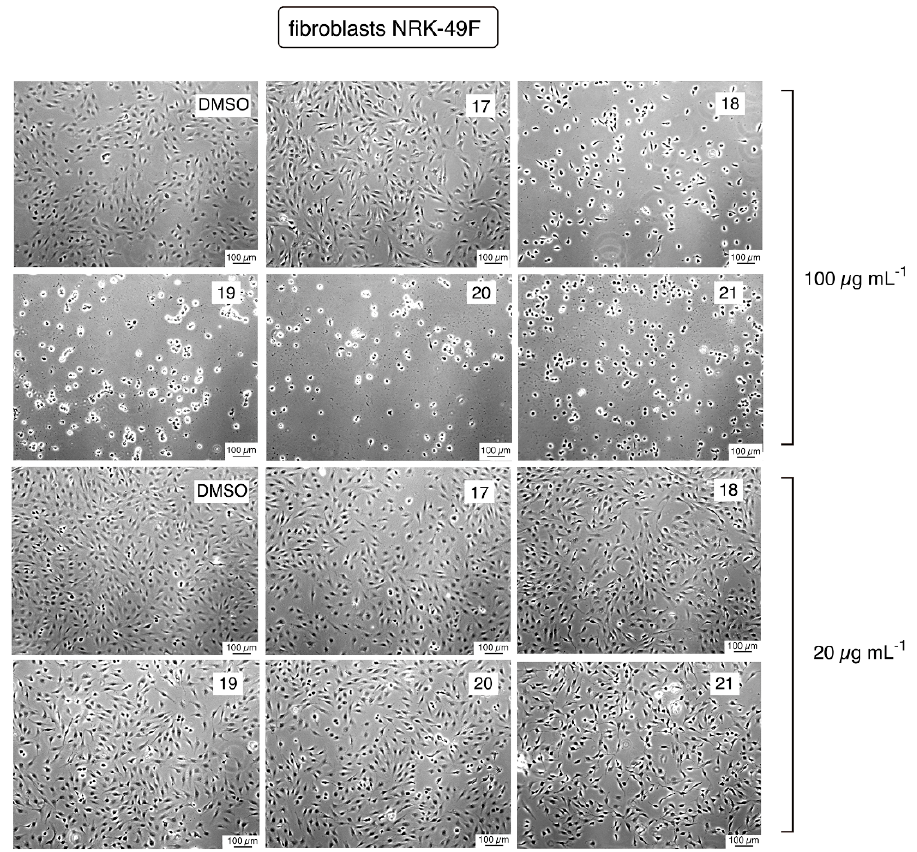
Figure 5. Toxicity assay of the series of compounds 17 – 21 in rat fibroblasts NRK-49F. The cell culture was exposed to the different compounds for 18 h at different concentrations (only two concentrations 100 µg mL − 1 or 20 µg mL − 1 are indicated). Cells were fixed and imaged in an inverted microscopy as described in Materials and Methods. In the case of compound 17, toxicity in NRK-49F fibroblasts was not observed at the highest concentration tested (100 µg mL − 1 ).